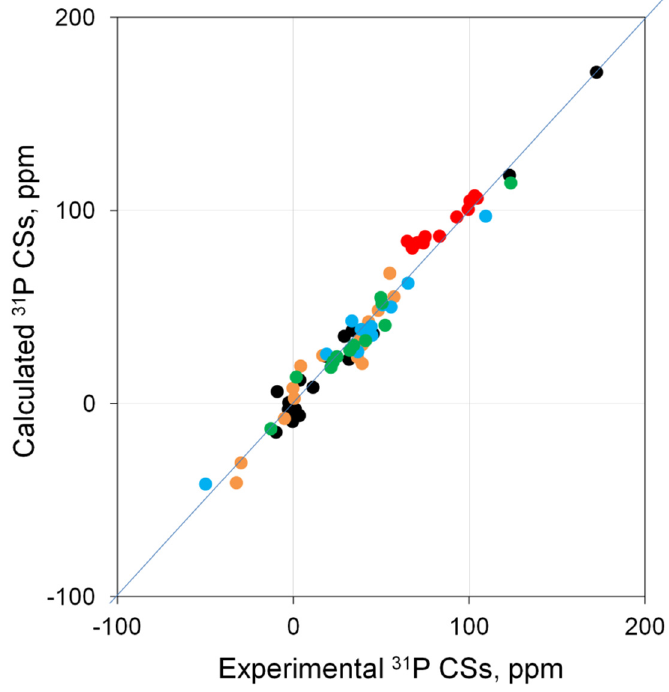
Figure 5. Correlation of calculated (PBE0/{6-311G(2d,2p); Pd(SDD)}//PBE0/{6-311+G(2d); Pd(SDD)}) vs. experimental 31 P CSs for palladium complexes 1 – 39 . Notation of the complexes is the same as that in Figure 1. Table 2. Empirical scaling factors obtained by the linear regression analysis of calculated and ex- perimental δ 31 P for the title Pd complexes.